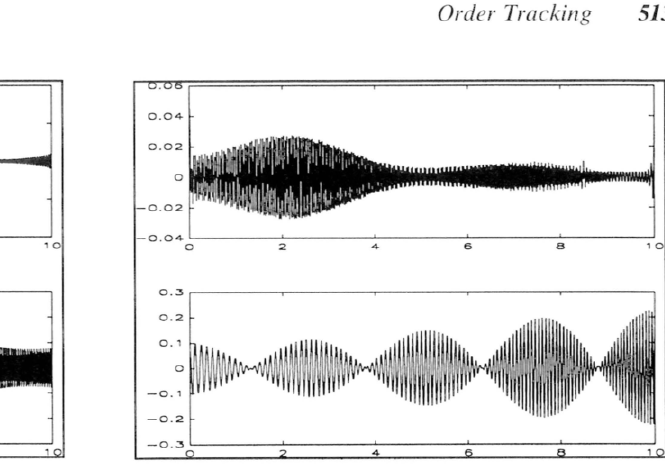
FIGURE 11 Tracking error of first harmonic with weighting 1/1 0 (top) and 1/ 100.